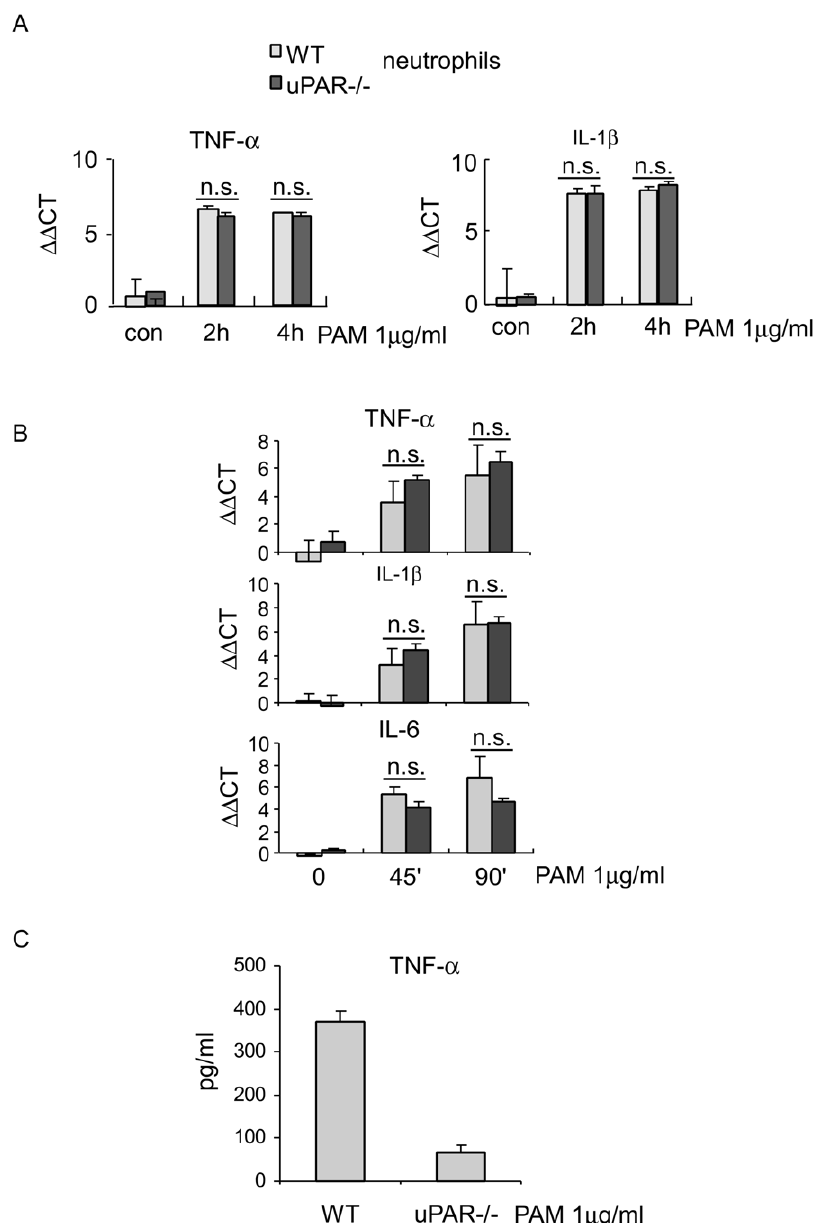
Figure 3. uPAR is not involved in the transcription of pro-inflammatory cytokines upon TLR2 stimulation in neutrophils. (A) 1 6 10 6 WT and uPAR-/- neutrophils were treated with 1 m g/ml PAM for 0, 2, or 4 hours. The cells were collected and total RNA from the cells purified. The mRNA levels of TNF- a and IL-1 b in the cells were determined by real-time PCR. n=3 for each condition; Mean 6 SD; All p values were greater than 0.05. (B) 1 6 10 6 WT and uPAR-/- neutrophils were treated with 1 m g/ml PAM for 0, 45, or 90 min. The mRNA levels of TNF- a , IL-1 b , and IL-6 in the cells were determined by real-time PCR. n=3 for each condition; Mean 6 SD; All p values were greater than 0.05. (C) 1 6 10 6 WT and uPAR-/- neutrophils were treated with 1 m g/ml PAM for 4 hours. The supernatants and the neutrophils were collected and cellular extracts prepared. The supernatants and the cellular extracts were mixed and the levels of TNF- a in the mixture were determined by ELISA assays. n=3 for each condition; Mean 6 SD. Results from two independent experiments are